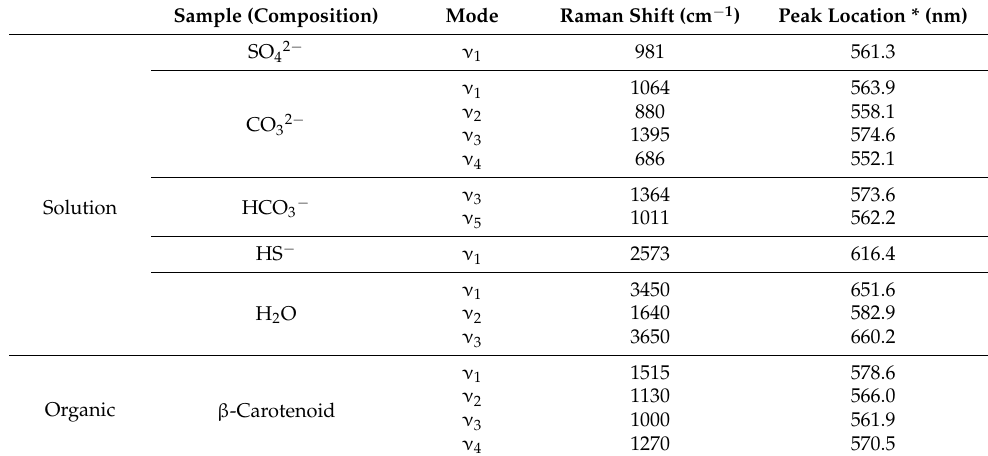
Table 3. Cont. Sample